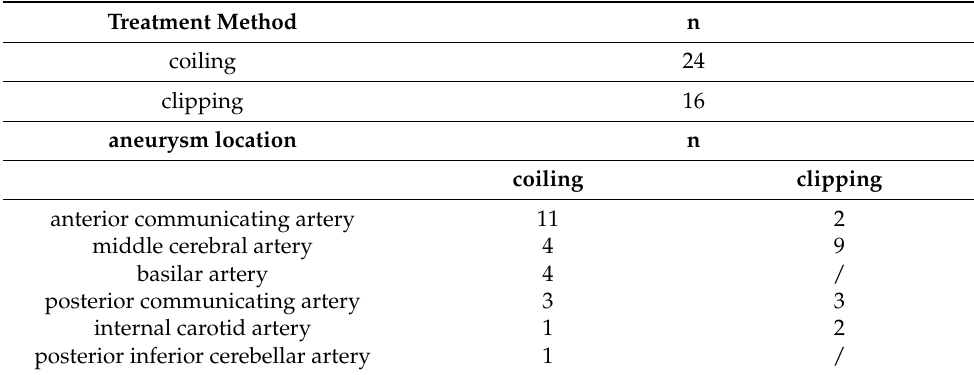
Table 3. Aneurysm